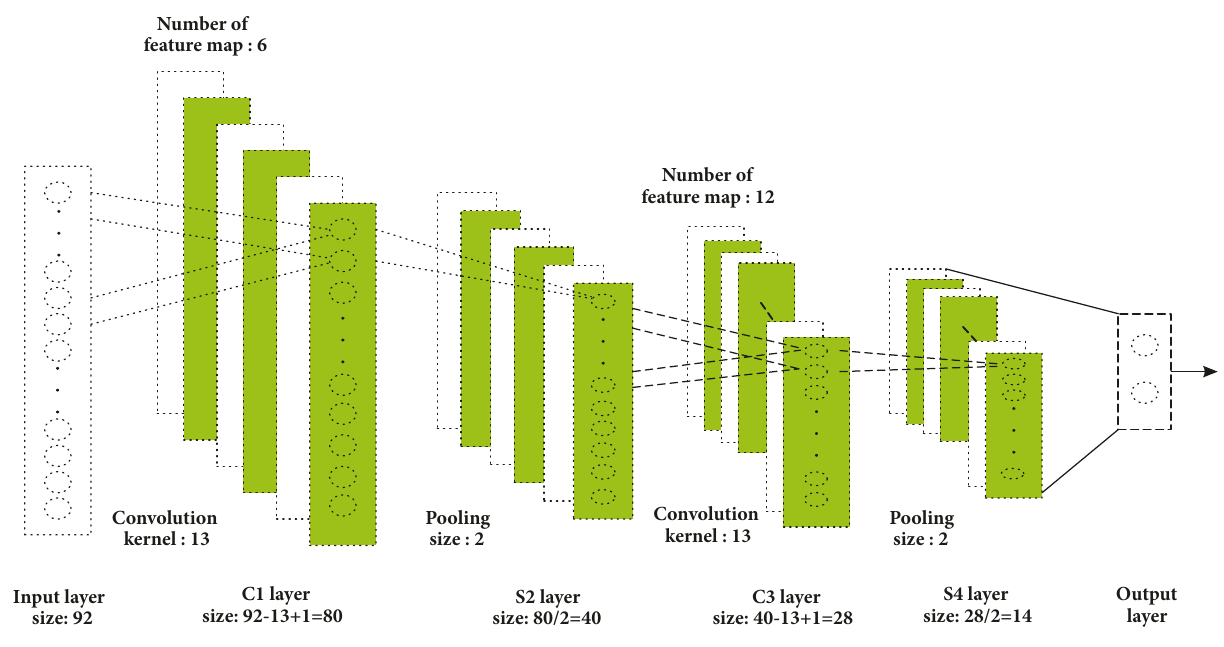
Figure 3: Structure diagram of the CNN.